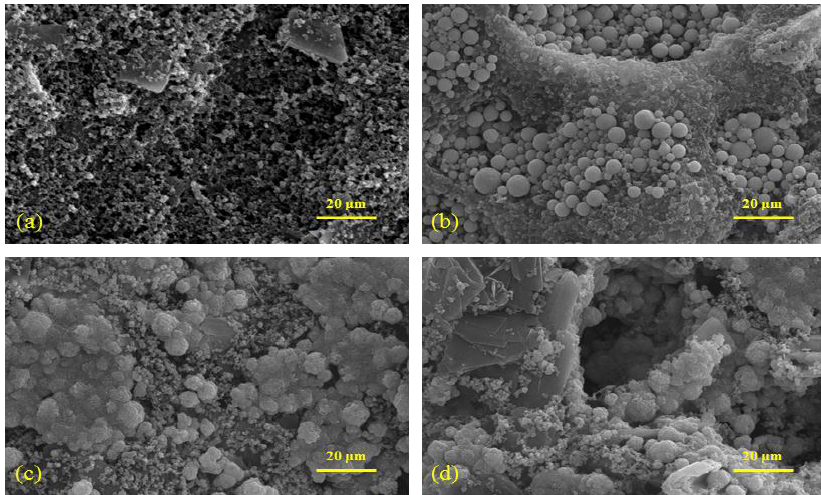
Figure 2. FE-SEM images (x10 K) of ( a ) pristine carbon ink printed ITO electrode, ( b ) printed 50 wt% nickel paste with carbon ink on the ITO electrode; ( c ) heated DSPNCE at 400 °C for 30 min and ( d ) electrodeposited Ni(OH) 2 /NiOOH on the DSPNCE.